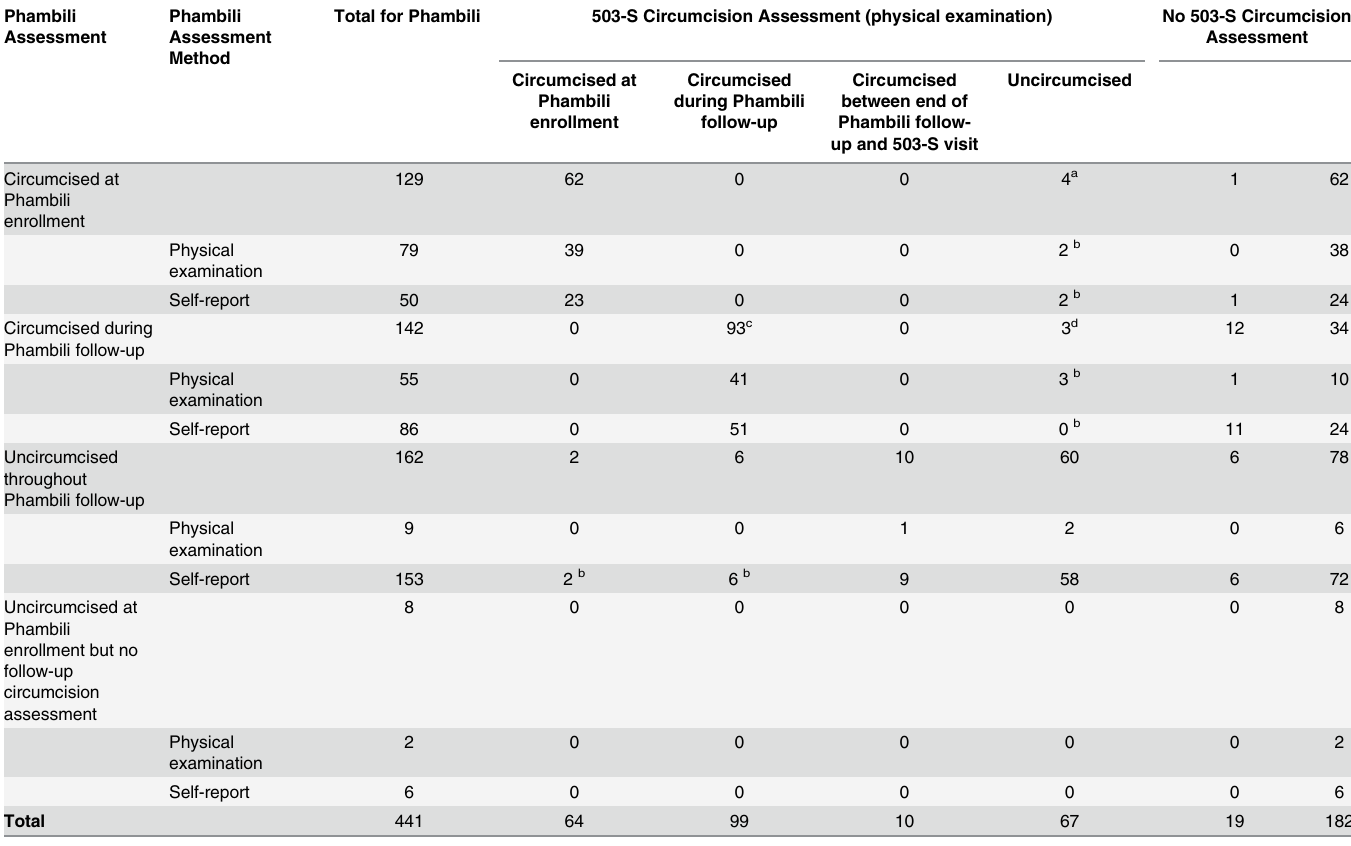
Table 4. Comparison for men of circumcision status from Phambili to HVTN 503-S assessment (N =